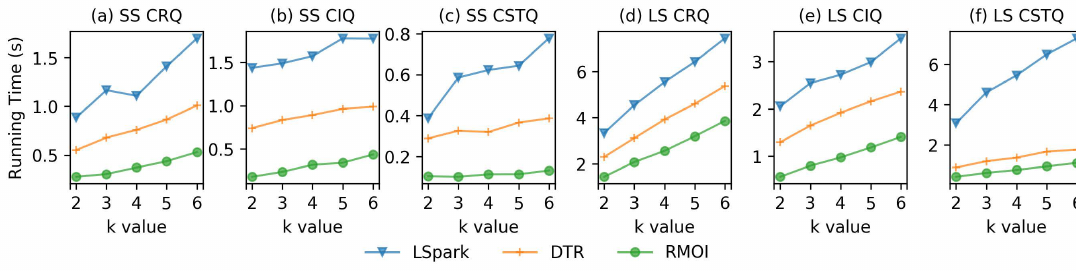
Figure 5. Average execution time for the SF dataset with low resource availability on ( a ) range query, ( b ) interval query, ( c ) lookup query, and ( d ) longest query.